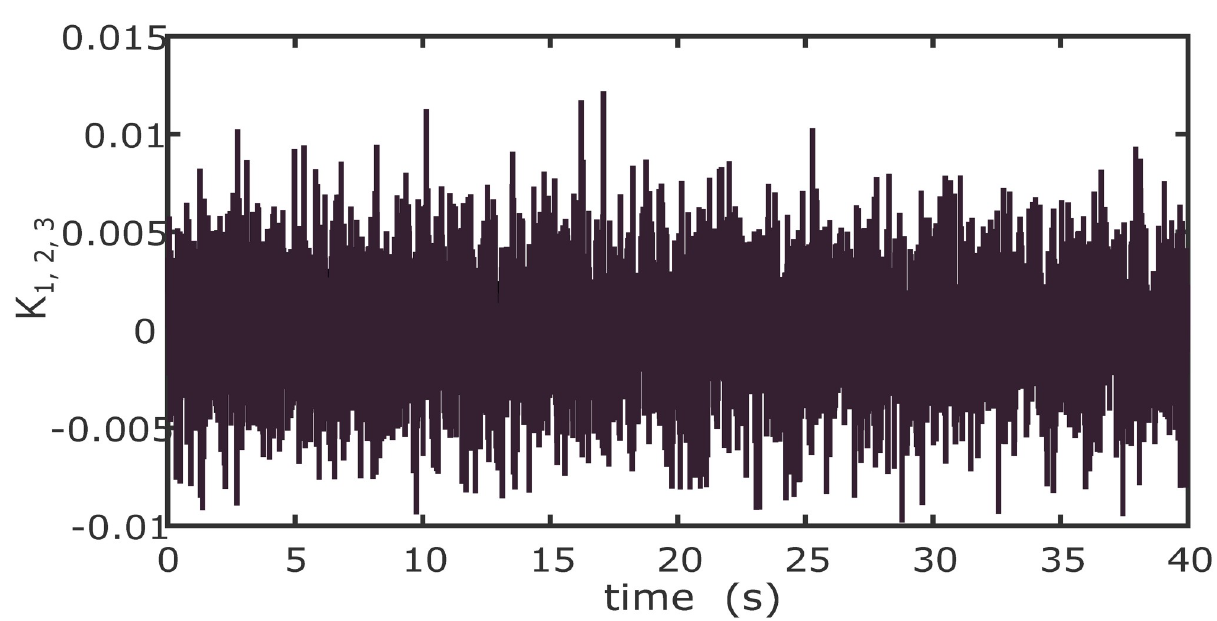
Fig 4. Drag coefficients for rotational